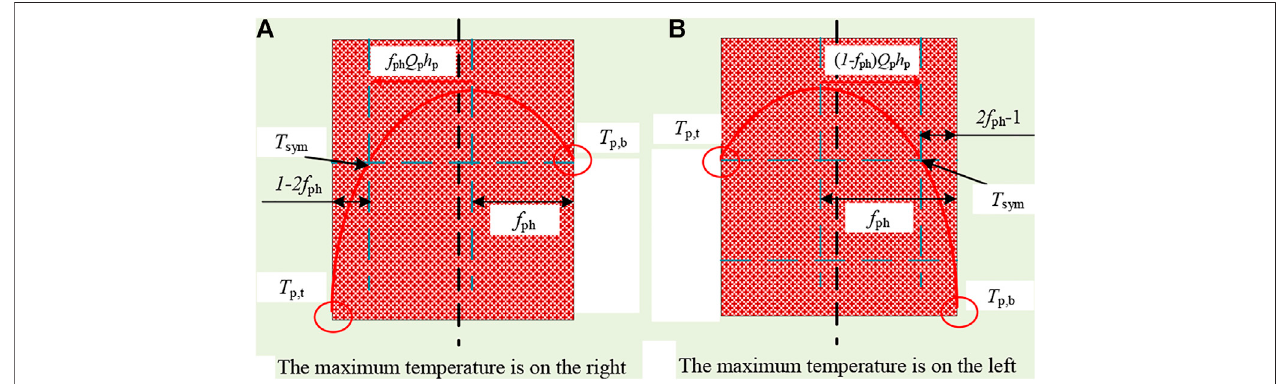
FIGURE7| Schematicdiagramoftemperaturesymmetryinthesolidoxidelayer. (A) Themaximumtemperatureisontheright. (B) Themaximumtemperatureison the